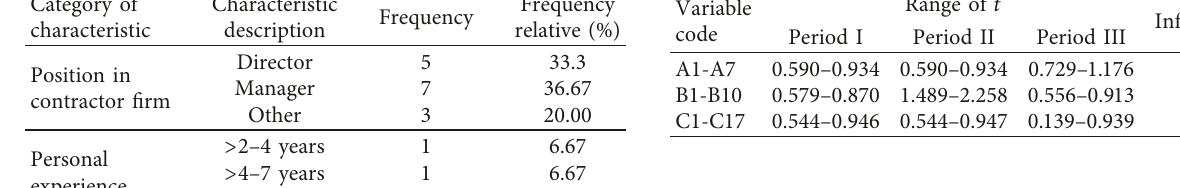
Table 7: Result of the validity test of SI data.